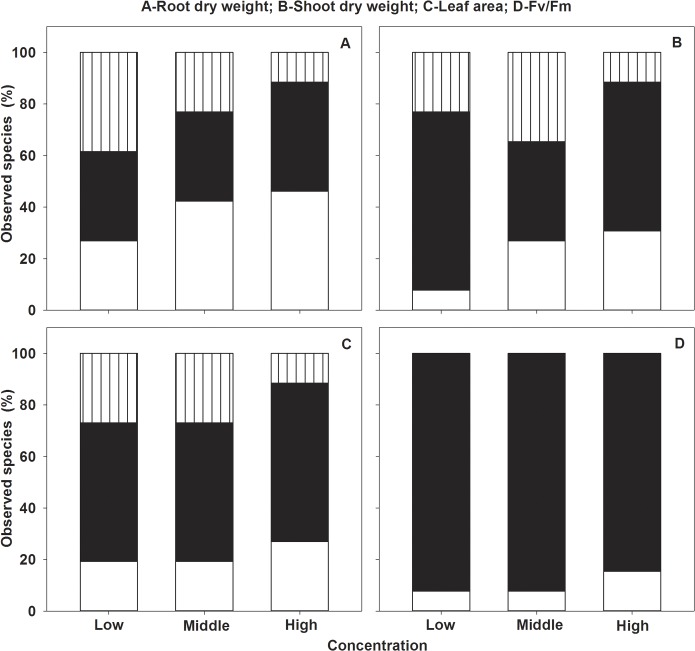
The three different allelopathic effects of Mikania on seedlings root dry weight (A), shoot dry weight (B), leaf area (C) and Fv/Fm (D) of the 26 target species in low, middle and high concentrations of leaf aqueous extract;negative effect(white), neutraleffect (black) and stimulated effect (batched).